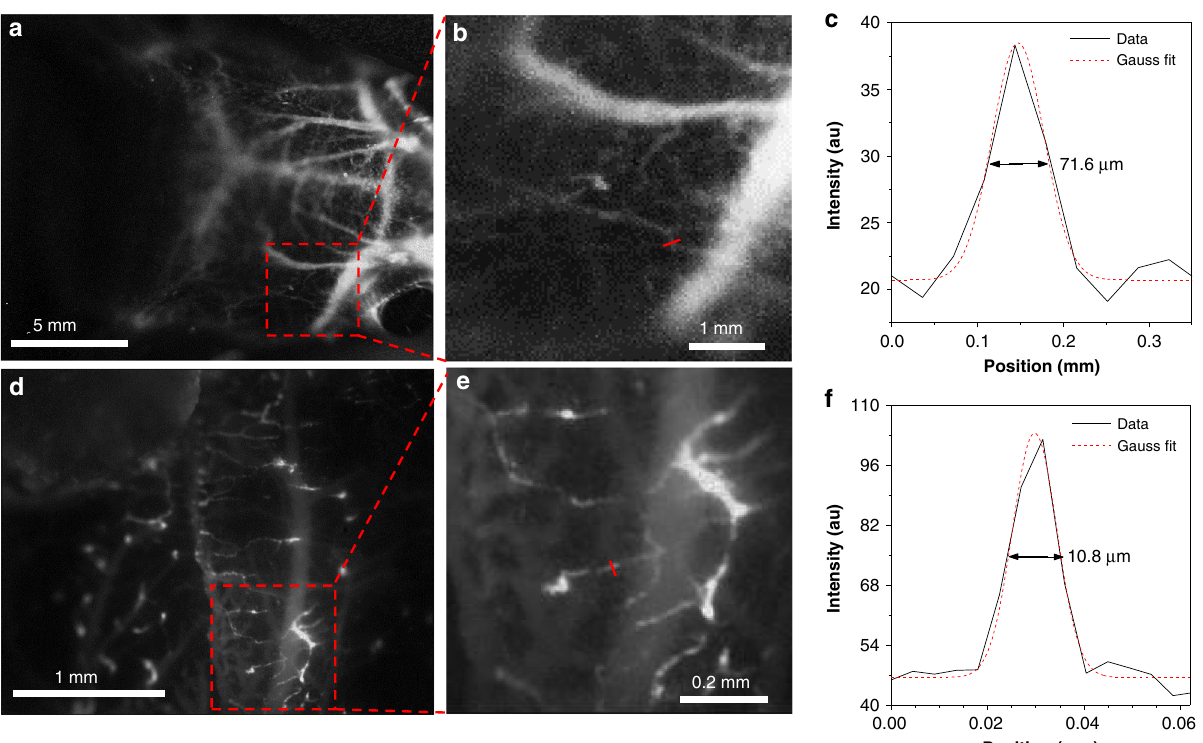
Fig. 6 NIR-IIb fl uorescence imaging of brain vasculature in living mice. a NIR-IIb fl uorescence image using a 50 mm fi xed focal lens. b Region of interest from the red-dashed box in ( a ). c Cross-sectional fl uorescence intensity pro fi le along the red line shown in ( b ). d NIR-IIb fl uorescence image using a scan lens (Thorlabs). e Region of interest from the red-dashed box in ( d ). f Cross-sectional fl uorescence intensity pro fi le along the red line shown in ( e ). Images were taken with a 793 nm laser excitation and the exposure time was 250